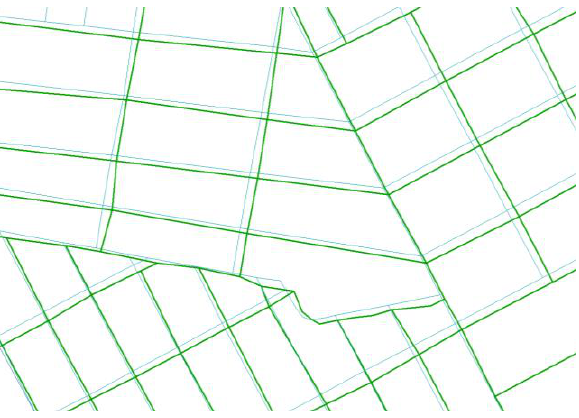
Figure 2. Geometric matching between OSM and reference